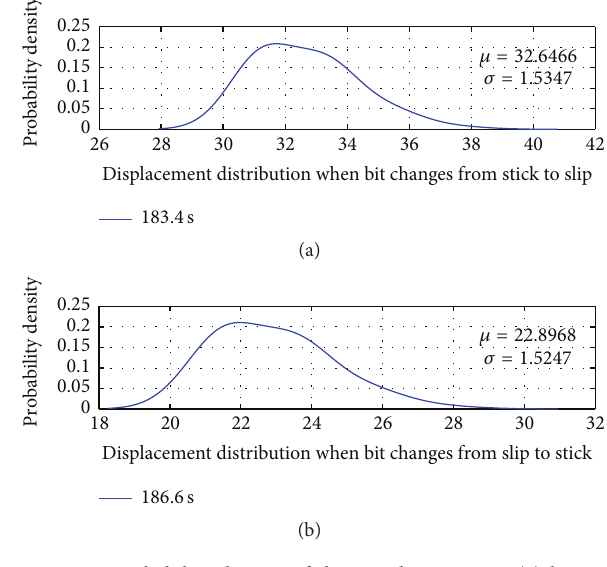
Figure 9: Probability density of the switching points: (a) leaving stick; (b) leaving